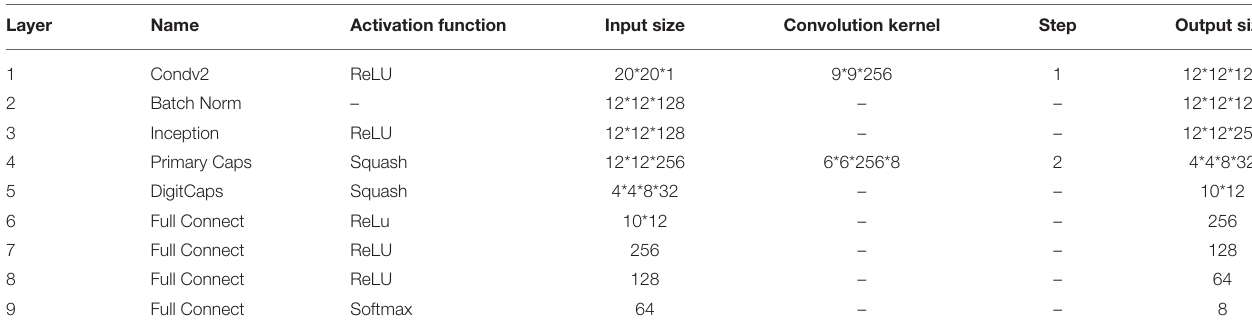
TABLE 1 | Capsule convolutional neural